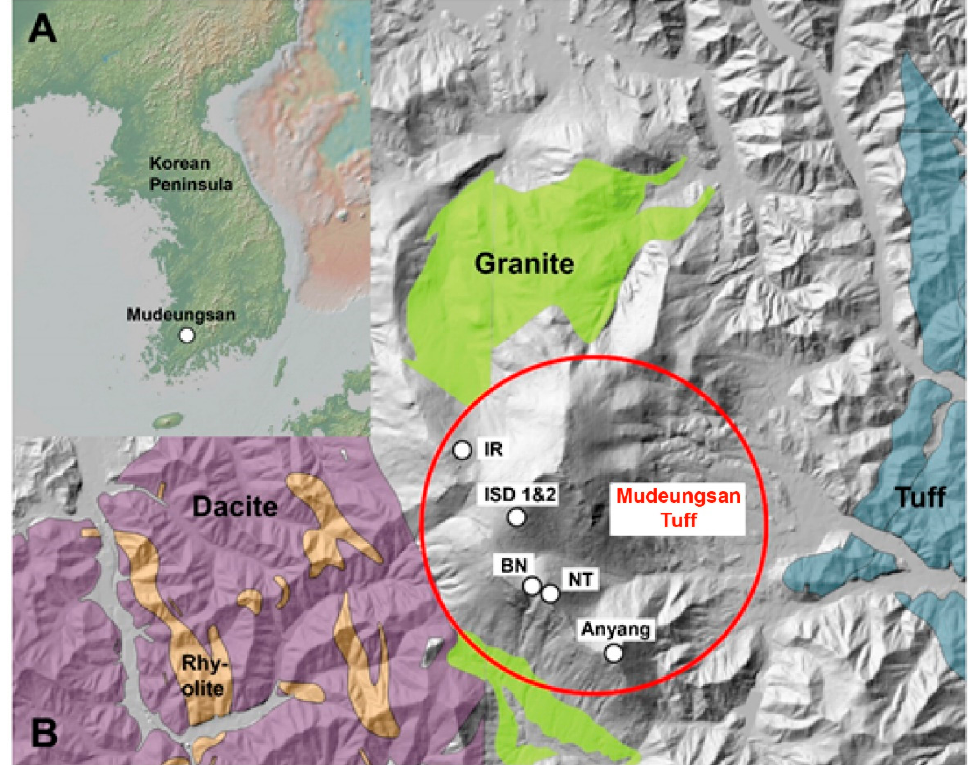
Figure 1. (A ) Location of Mudeungsan in the southwestern Korean Peninsula. ( B ) Geological map of Mudeungsan (geological information was obtained from Lim et al. (2015)). Locations of the Mudeungsan tuff samples are shown as white circles. The area marked with a red circle was reported to be Mudeungsan tuff by Lim et al. (2015).